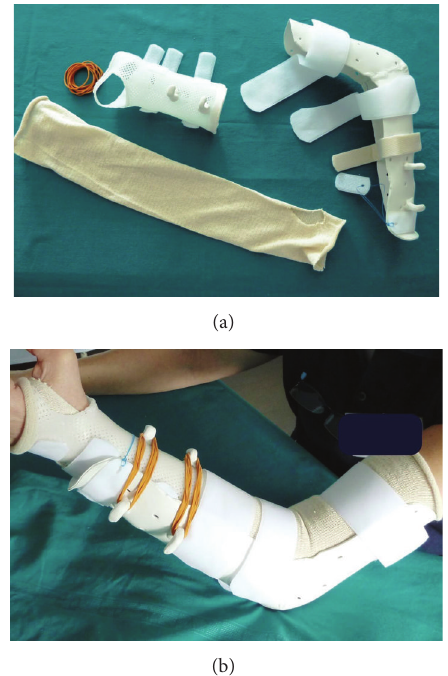
Figure6:Thecustom-madedynamicsplintworksinthefirstmonth to act in static progressive mobilization and from the second month starts an active